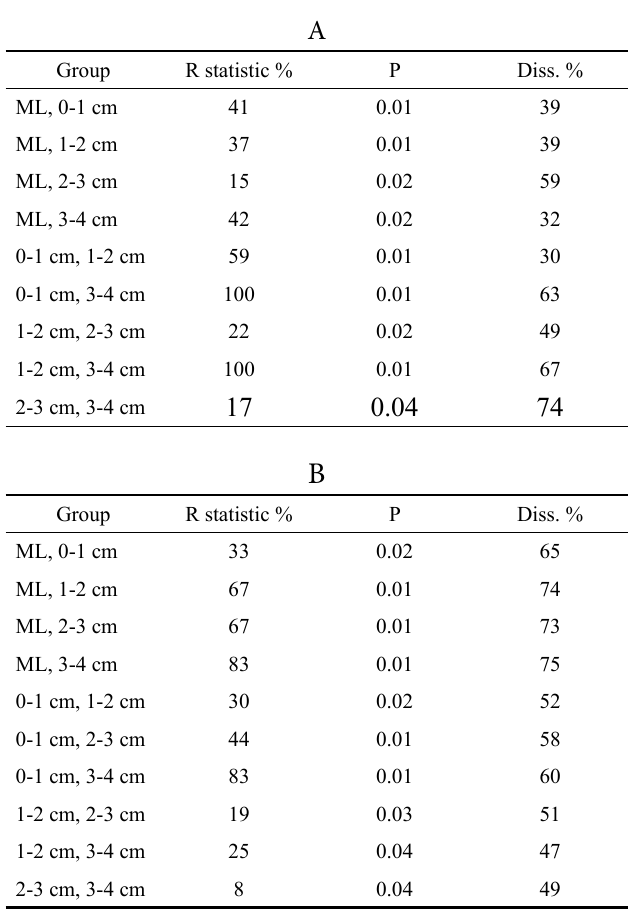
Table S1. – ANOSIM (R statistic), significance level (P) and SIMPER results (Diss., Dissimilarity %). A. most abundant higher meiofaunal taxa. B. nematode